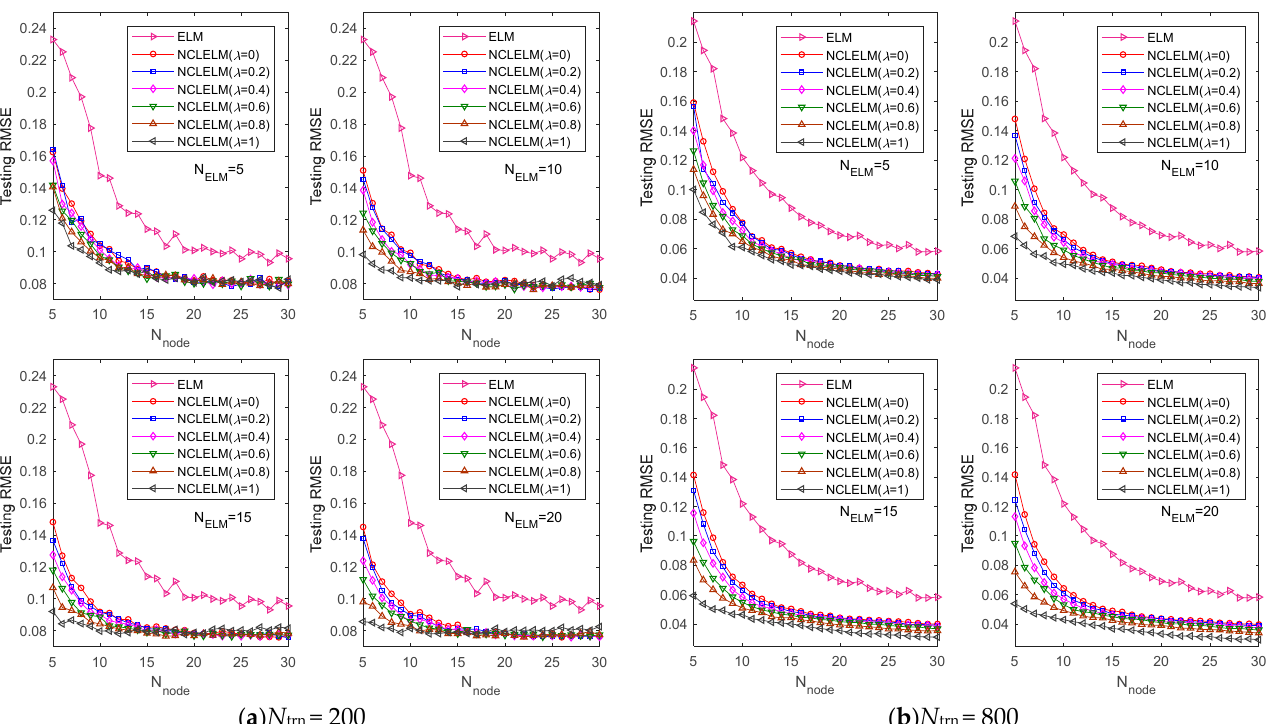
Figure 5. Prediction results of the ELM, EnELM, and NCLELM methods under different parameter settings. In ( a , b ), the training sample size was N trn = 200 and 800, respectively.